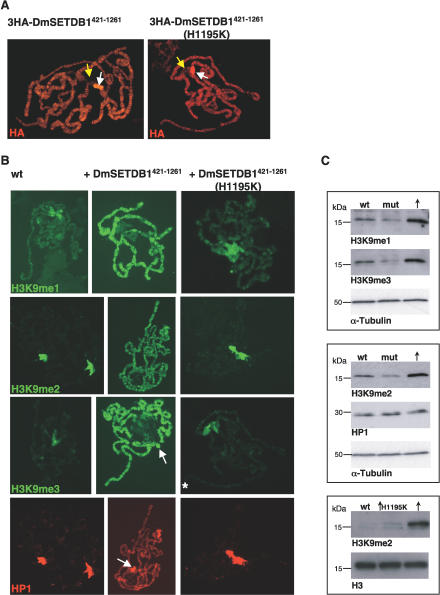
Overexpression of DmSETDB1421–1,261 Induces Increase in H3K9 Mono-, Di-, and Trimethylation(A) Salivary glands polytene chromosomes from larvae expressing 3HA-DmSETDB1421–1,261 (CaSpeR-3HA-DmSetdb1421–1,261) or 3HA-DmSETDB1421–1,261(H1195K) (UAS-3HA- DmSetdb1421–1,261(H1195K) daGal4 homozygotes) were immunostained with α-HA. For the 3HA-DmSETDB1421–1,261, larvae were subjected 30 min at 37 °C heat shock and placed 1 h at room temperature for recovery before squashing. 3HA-DmSETDB1421–1,261 and 3HA-DmSETDB1421–1,261 (H1195K) localize at the Chromosome 4 and on the euchromatic arms. White arrows point at the Chromosome 4 and yellow arrows at the chromocenter.(B) Immunostaining of salivary gland polytene chromosomes of wild-type (wt), overexpressing DmSETDB1421–1,261 (UAS-DmSetdb1421–1,261 daGal4 homozygotes), and overexpressing mutant DmSETDB1421–1,261(H1195K) (UAS-DmSetdb1421–1,261(H1195K) daGal4 homozygotes) third instar larvae. The chromosome with a white asterisk corresponds to the overexpression of the 3HA-tagged protein. Chromosomes were stained with antibodies recognizing H3K9me1, me2, me3, or HP1. Overexpression of DmSETDB1421–1,261 but not of mutant DmSETDB1421–1,261(H1195K) leads to a strong increase of H3K9me1, me2, and me3 signals on the euchromatic arms and on the Chromosome 4 (white arrow on H3K9me3 panel); moreover HP1 is recruited to euchromatic arms and strongly binds Chromosome 4 (white arrow on HP1 panel).(C) Top and middle panels: Western Blot analysis on 20 μg brain, salivary glands, and imaginal discs extracts (dissected together) of wild-type (wt), DmSetdb110
.1a homozygote mutant (mut), overexpressing DmSETDB1421–1,261 (↑) (UAS-DmSetdb1421–1,261 daGal4 heterozygotes) third instar larvae. First membrane was probed with α-H3K9me1 and α-α-tubulin, stripped, and probed with α-H3K9me3. Second membrane was probed with α-H3K9me3 and α-tubulin, stripped, and probed with α-HP1. Bottom panel: 5 μg brain extracts from wild-type (wt), overexpressing mutant DmSETDB1421–1,261(H1195K) (↑H1195K) (UAS- DmSetdb1421–1,261[H1195K] daGal4 homozygotes), and overexpressing DmSETDB1421–1,261 (↑) (UAS-DmSetdb1421–1,261 daGal4 homozygotes) of third instar larvae were loaded twice and membranes were probed with α-H3K9me2 or α-H3.